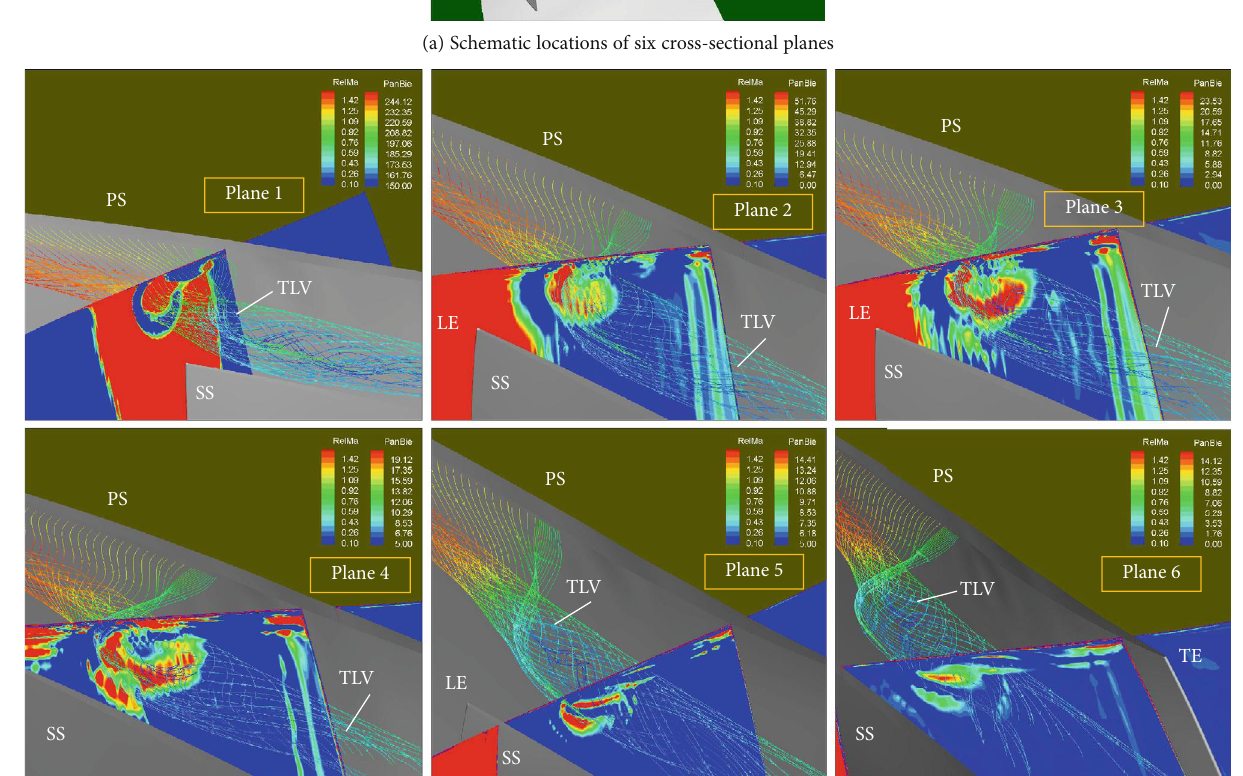
Figure 27: Identi fi cation of TLV existence by parameter PanBie at near stall